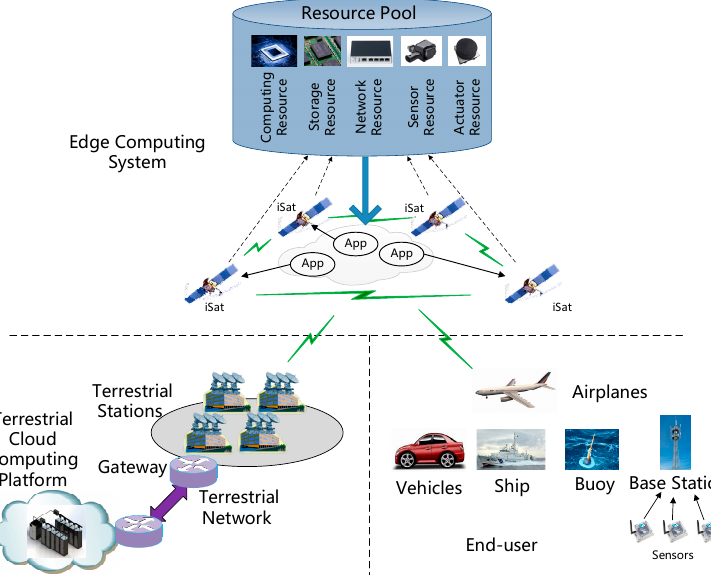
Figure 1. The architecture and application of satellite edge computing.